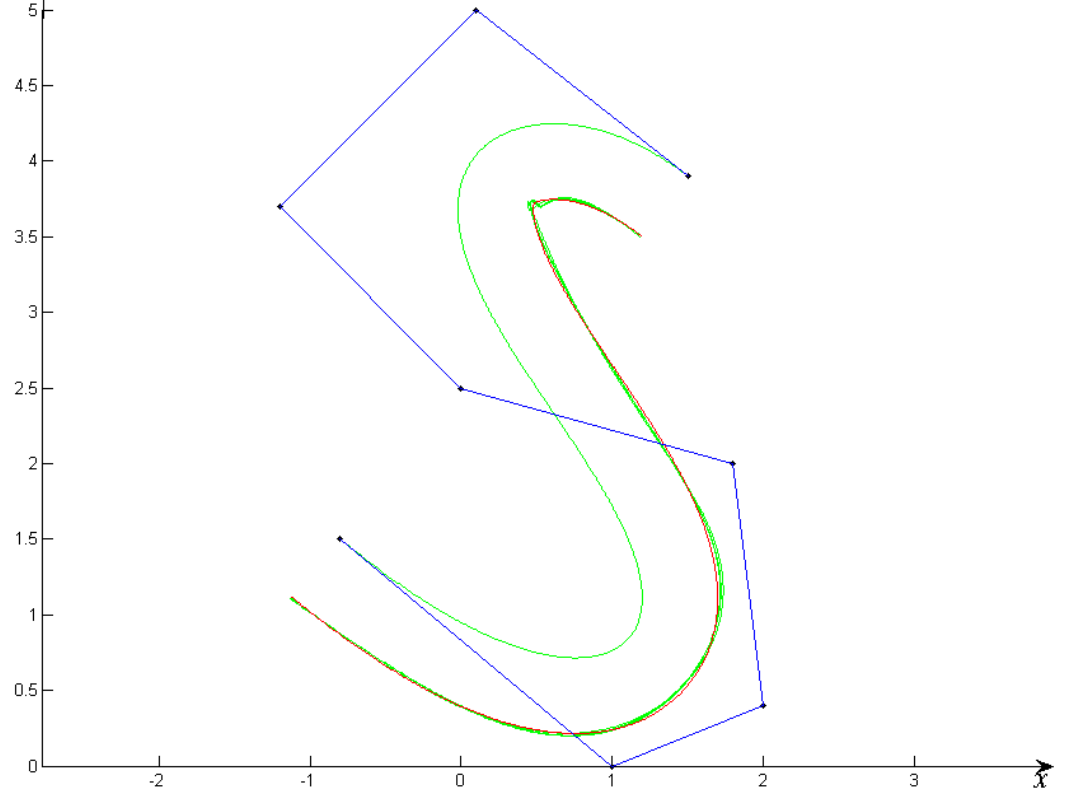
Figure 2. The septic Bézier curve and the offset. The original curve is the thin green curve with a control net. The offset is the red curve, and the approximating offset is the thick green curve.